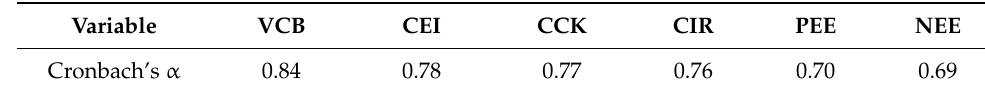
Table 3. Reliability indices.